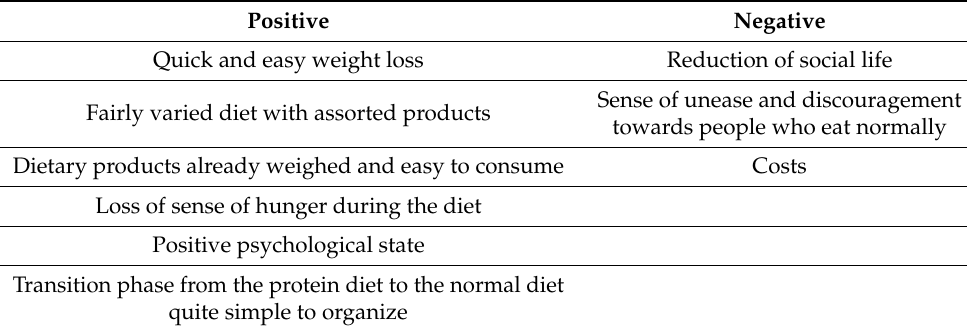
Table 4. Patient’s personal perspective regarding the